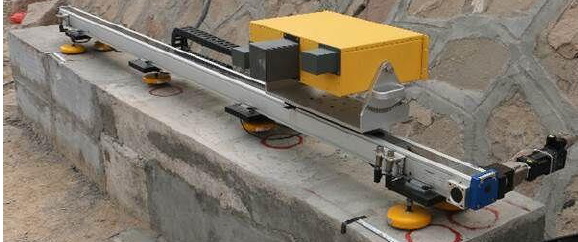
Figure 3. Rail error in the range detection. (a) Interferogram containing 20mm rail error in the range direction. (b) 20mm rail Figure 5. GB-SAR system used in the experiment error competition result. (c) Interferogram containing 85mm rail error in the range direction. (d) 70mm rail error compensate result.